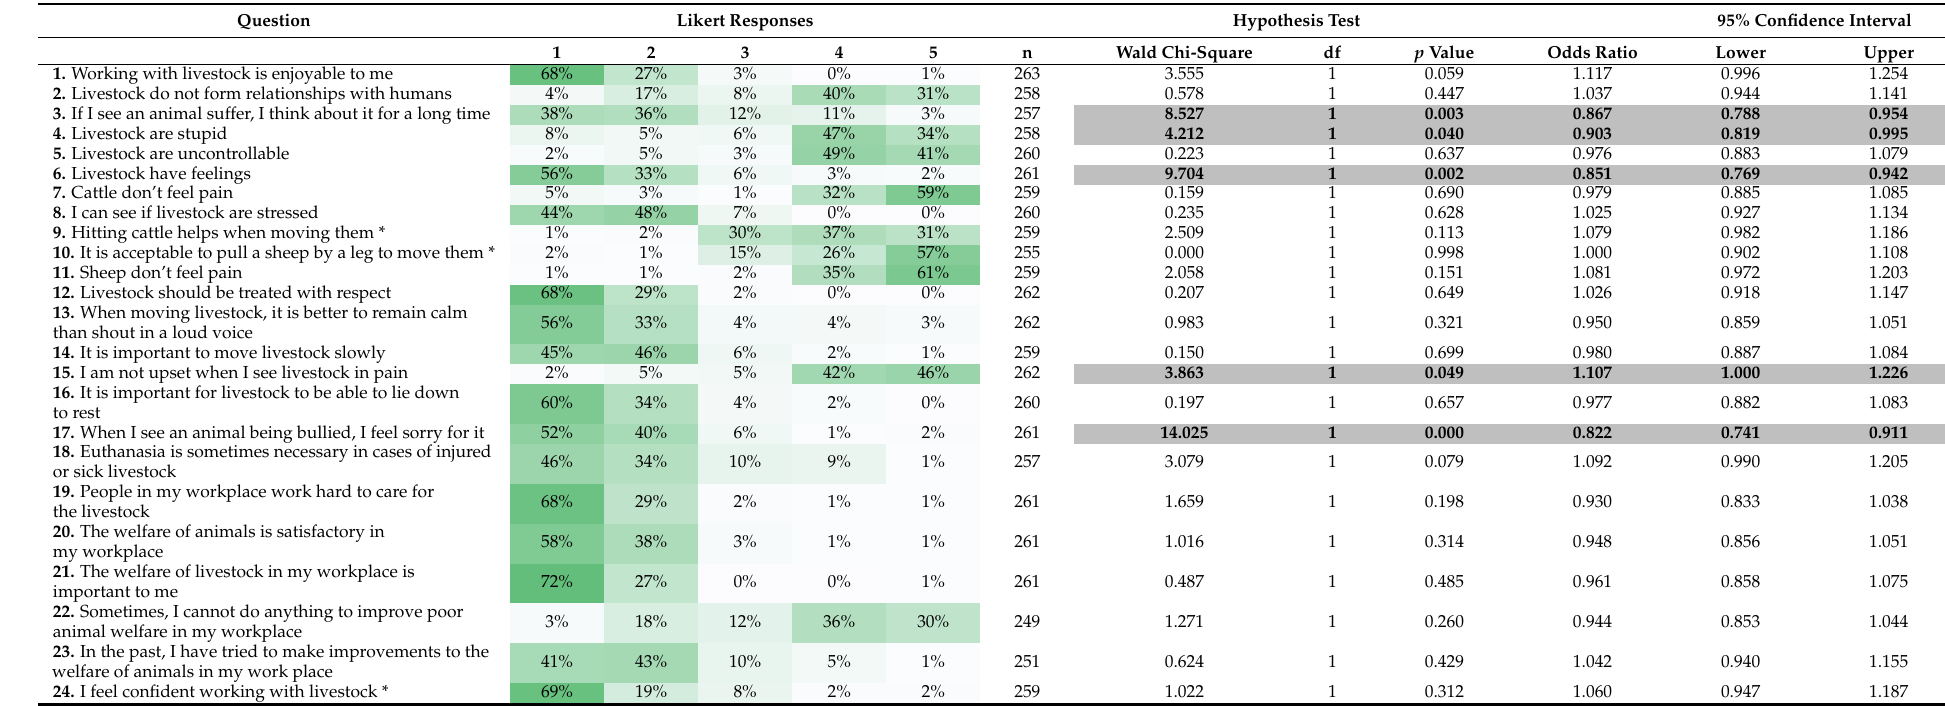
Table 1. Overall responses to Likert scale questions. Cells are shaded to indicate the fewest (white) to the most frequent (dark green) responses. Right hand columns show the results of ordinal regression analyses. Questions that demonstrated a significant difference in Likert scores by role in industry, and the probability that those responses varied significantly, are highlighted in grey and denoted in